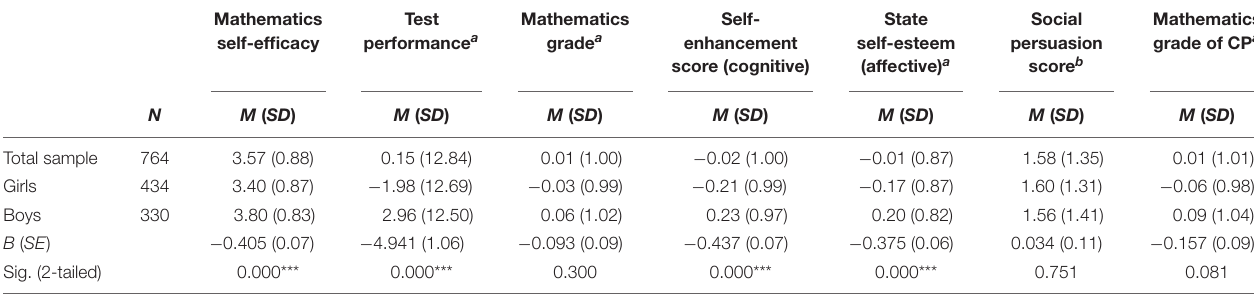
TABLE 1 | Summary of means and standard deviations as a function of